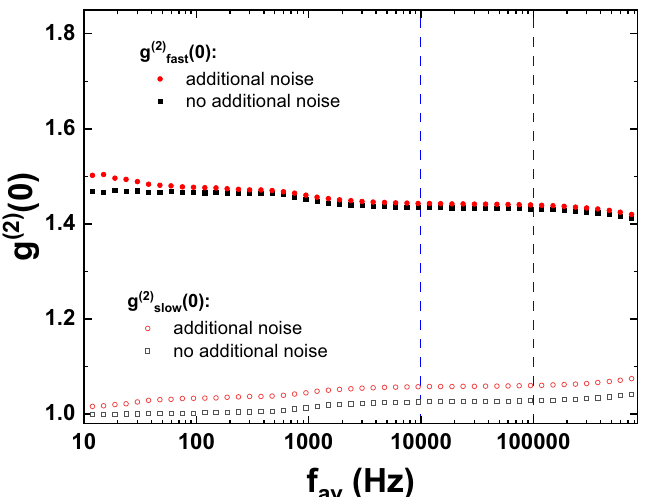
Figure 2. Photon correlation function of a polariton condensate driven far above threshold versus averaging ( 2 ) ( 0 ) , which corresponds to noise contributions at frequencies above f av , frequency f av . Full symbols denote g fast ( 2 ) ( 0 ) , which corresponds to noise contributions at frequencies below f av . Results while open symbols denote g slow for standard operation and operation in the presence of additional mechanical noise are compared. Dashed ( 2 ) ( 0 ) represents the intrinsic photon number noise of the emission from the lines indicate the region, where g fast